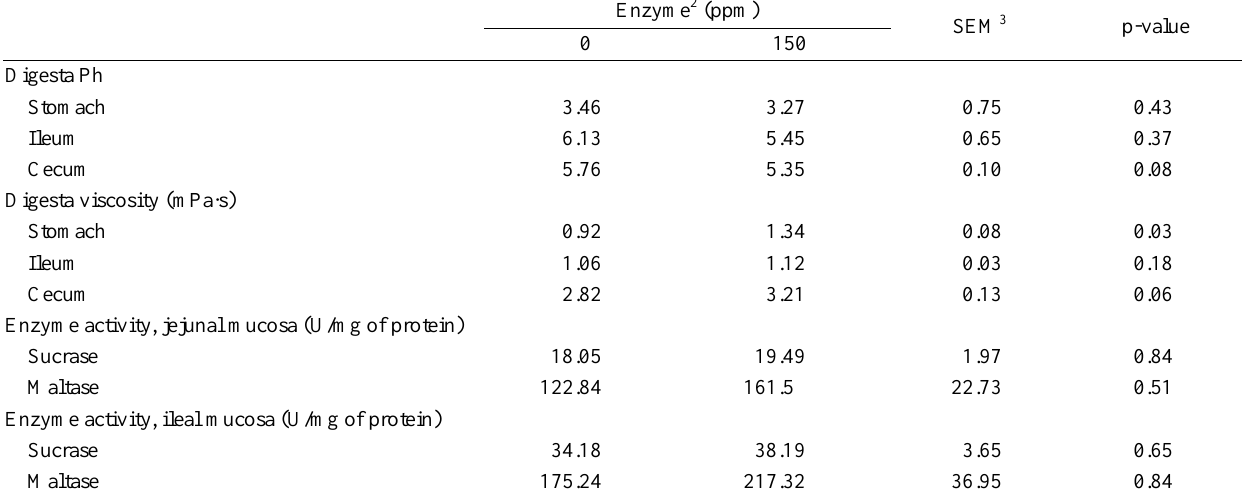
Table 6. Effects of enzyme supplementation on digesa viscosity, pH and jejunal and ileal mucosa enzymatic activity of weaned pigs